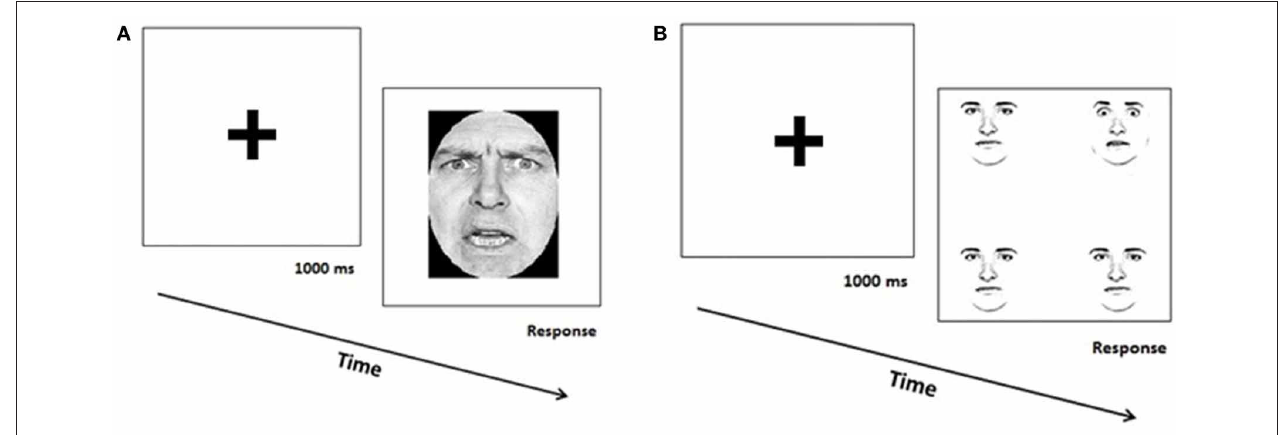
FIGURE 1 | Trial sequence in Experiment 1 showing an angry facial expression (A), and in Experiment 2 showing of a target-present condition with a target fearful expression (B).